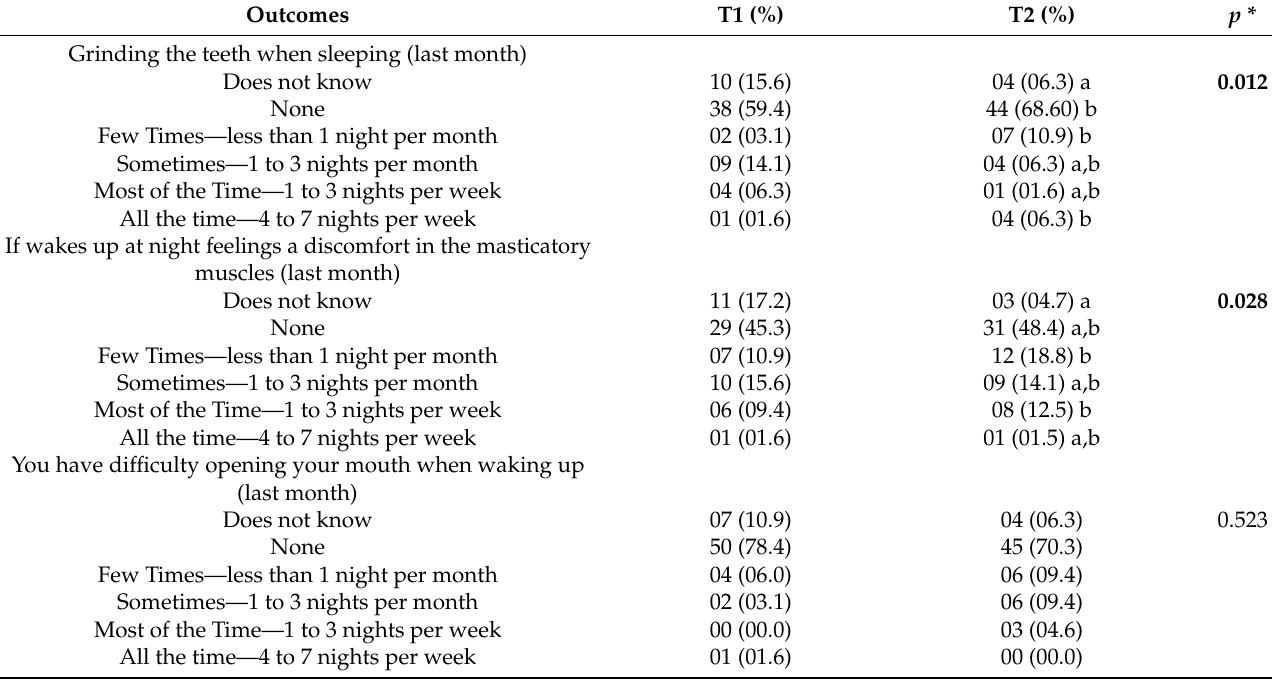
Table 1. Comparative analysis between sleep bruxism reported before the pandemic (T1) and in the first period of mandatory confinement by COVID-19 (T2).